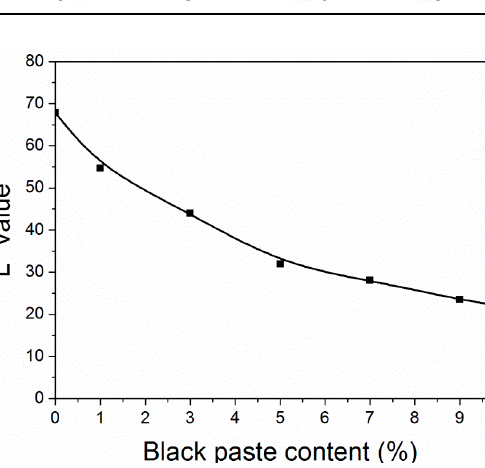
Figure 2. Effect of black paste content on the L * value of the coatings. Figure 2. E ff ect of black paste content on the L * value of the